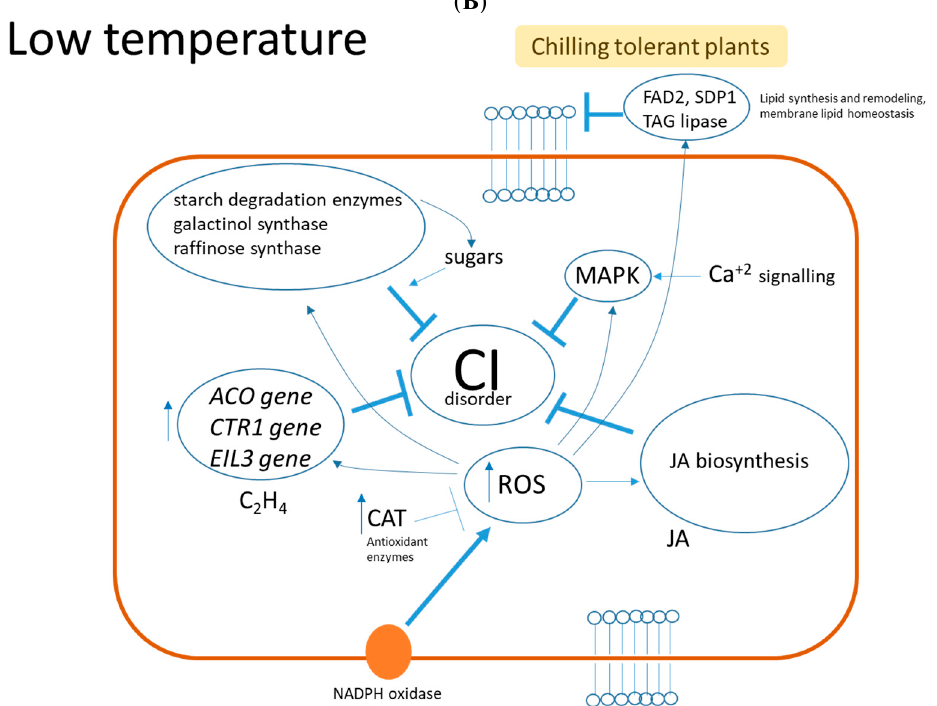
Figure 4. Proposed models of chilling sensitive and chilling tolerant plants based on a dual role mode of action of oxidative stress. ( A ) In chilling sensitive plants, low temperature storage induces higher levels of oxidative stress (e.g., ROS source from chloroplast, mitochondrial and NADPH oxidase activity) and less membrane fluidity. This in turn further damages membrane functionality, induces DNA and RNA damage, alters protein functionality, and enhances phenolic biosynthesis and polymerization, while the intrinsic antioxidant system is overwhelmed by ROS levels causing CI symptoms. ( B ) In chilling tolerant plants, low temperature storage induces several protective mechanisms against CI including induced ethylene and jasmonic acid biosynthesis, released sugar levels are induced, membrane protective mechanisms, induced Ca +2 and MAPK signaling, and an enhanced antioxidant system which attenuates and maintains low oxidative stress levels induced mainly by NADPH oxidase. These low ROS levels signal the above protective mechanisms in tolerant plants against CI. CAT, catalase, C 2 H 4 , ethylene, JA, jasmonic acid, CI, chilling injury, ROS, reactive oxygen species, PAL, phenylalanine ammonia lyase, PPO, polyphenol oxidase, LOX, lipoxygenase. Proposed hypothetical models are based on references from Section 2.